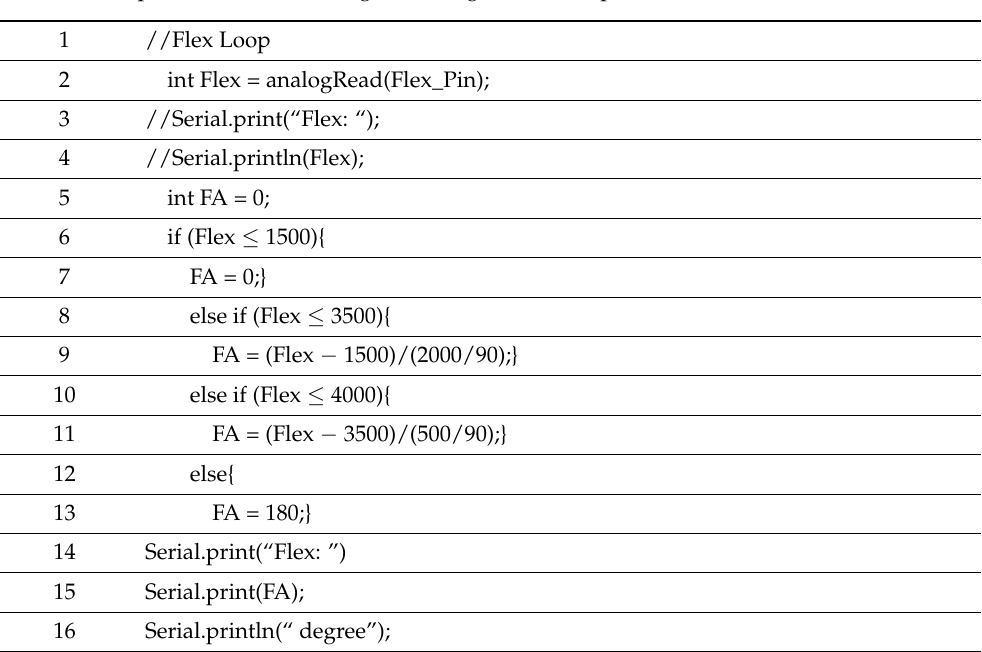
Table 11. The pseudo-code of the finger bending and flex